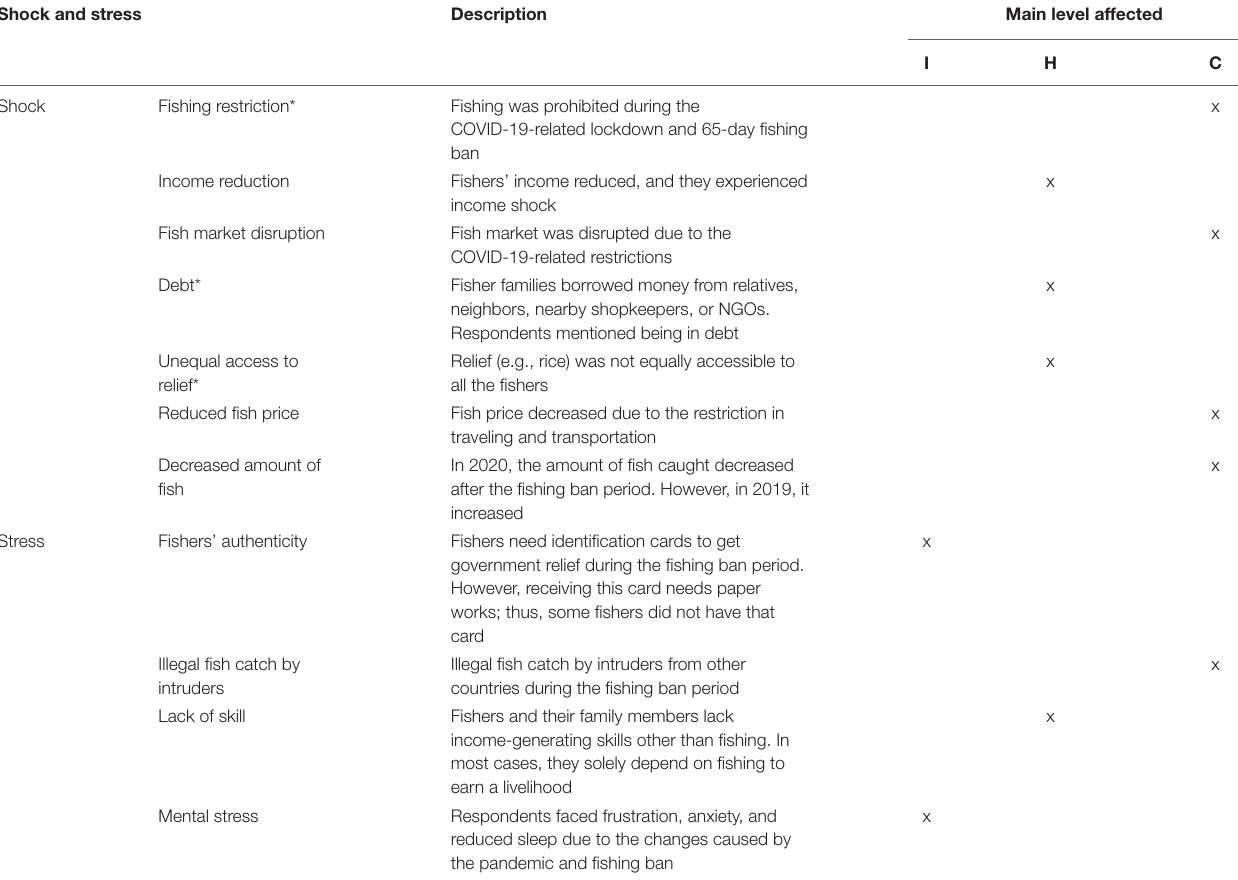
TABLE 1 | Shocks and stresses mentioned by the